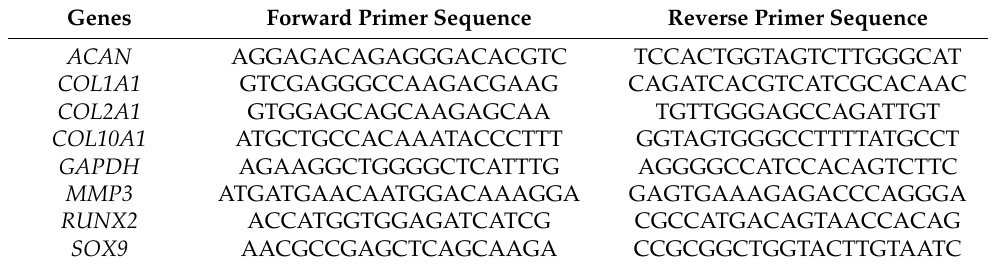
Table 1. Genes and their primers used for quantitative real-time polymerase chain reaction